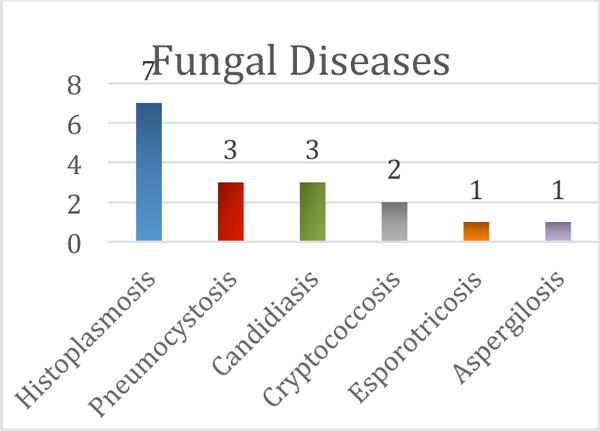
Fungal diseases.